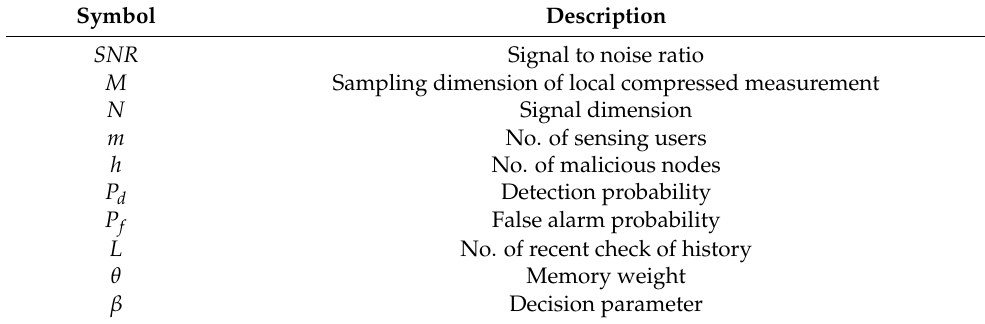
Table 1. Nomenclature.